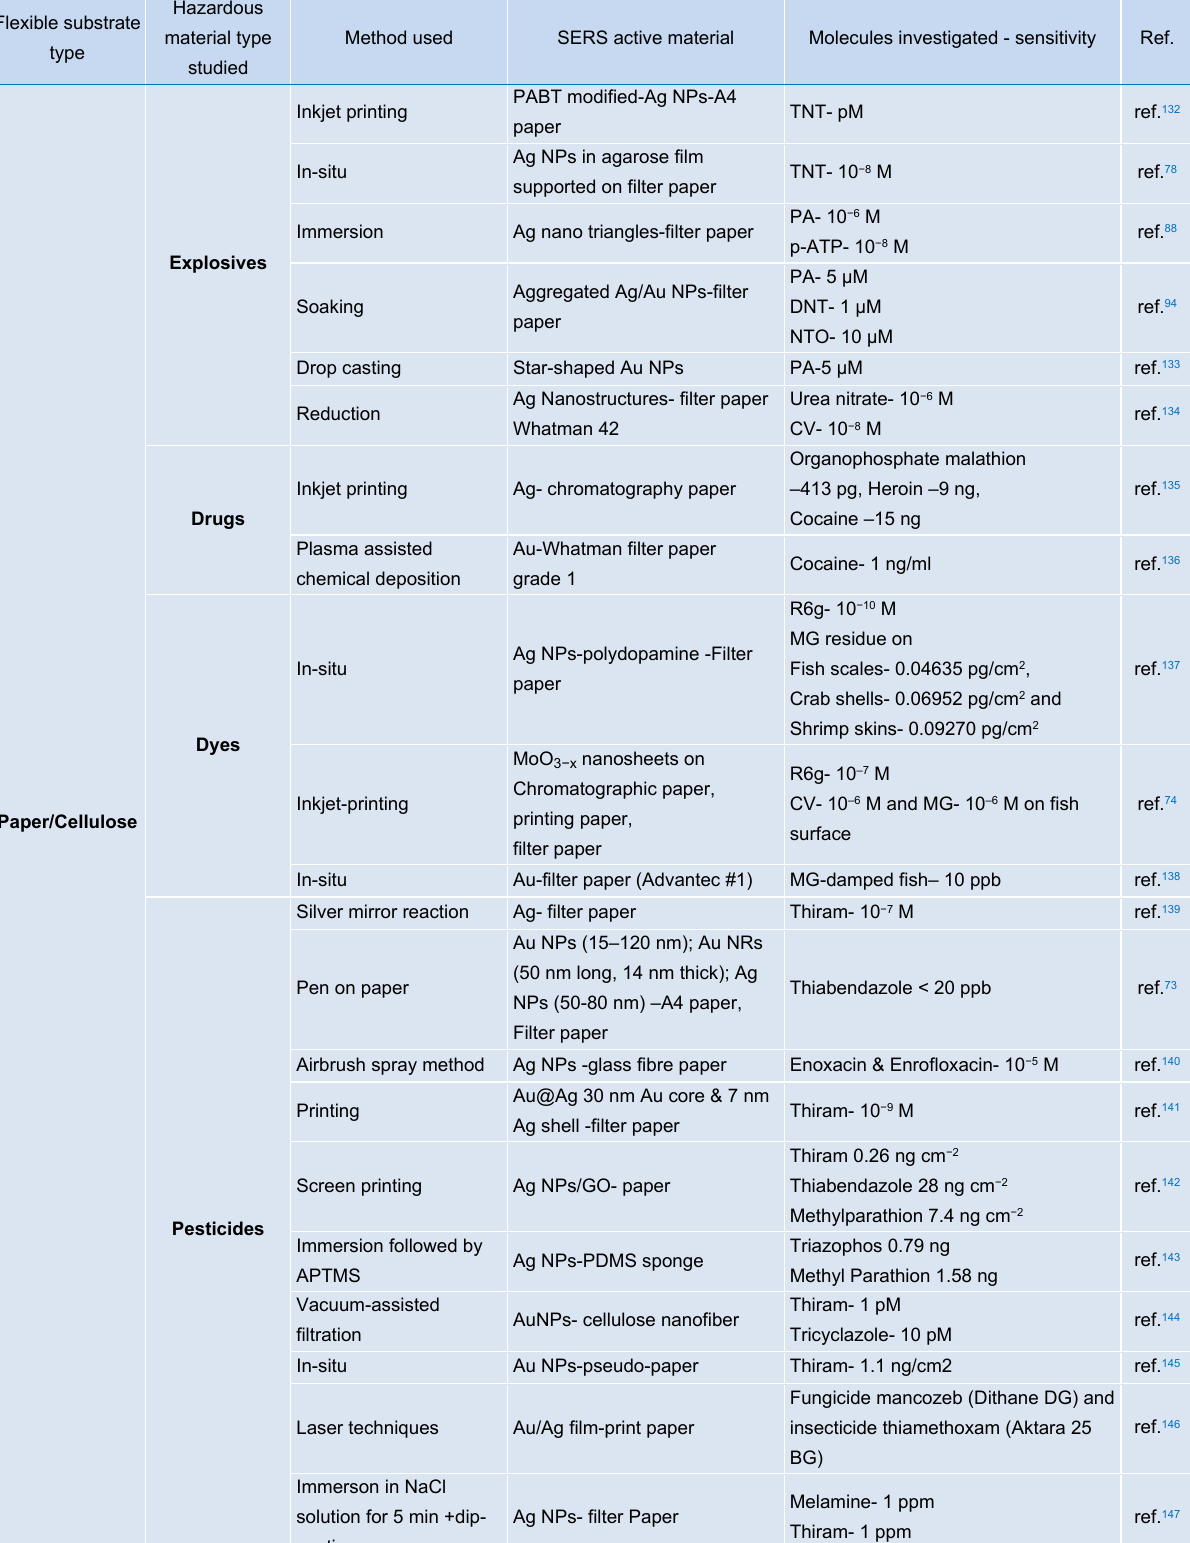
Table 2 | Summary of the recent flexible SERS substrates, their preparation methods, materials used, and the sensitivities achieved